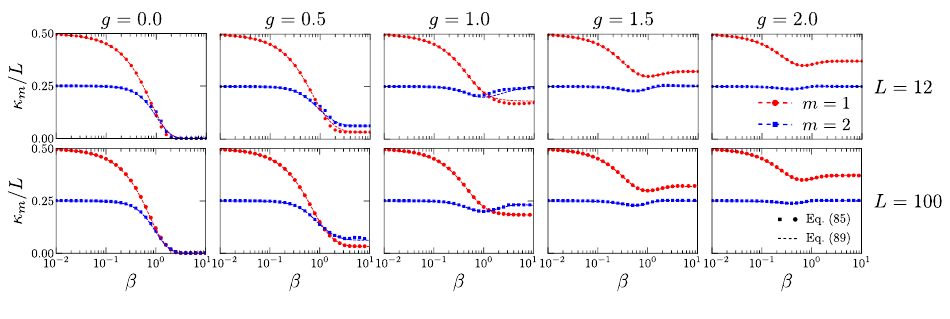
Figure 5: Cumulants of the kink-number distribution as a function of the inverse of temperature β . Using the exact characteristic function given by Eq. (85), the mean kink number κ and the variance κ are shown by red circles and blue squares, 1 2 respectively. The dashed lines correspond to the numerical results using the PPA characteristic function in Eq. (89). While in the paramagnetic phase the statistics is sub-Poissonian, in the ferromagnetic phase it changes from sub- to super-Poissonian as the temperature is decreased. The magnetic field is increased from 0.0 to 2.0, varying from left to right in steps of 0.5. In the upper panels, the system size is L = 12, while in the lower ones L =